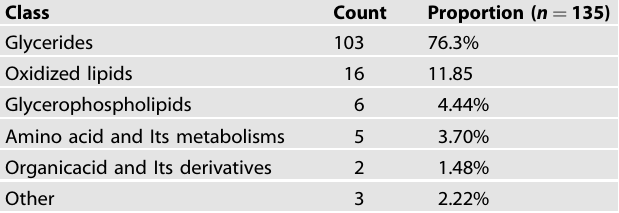
Table 3. The Class of signi fi cantly different